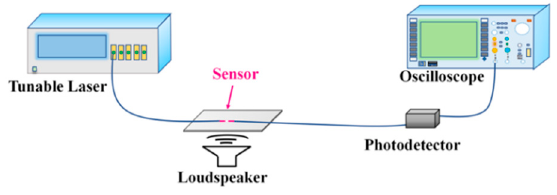
Figure 6. Schematic setup for the acoustic vibration sensing.